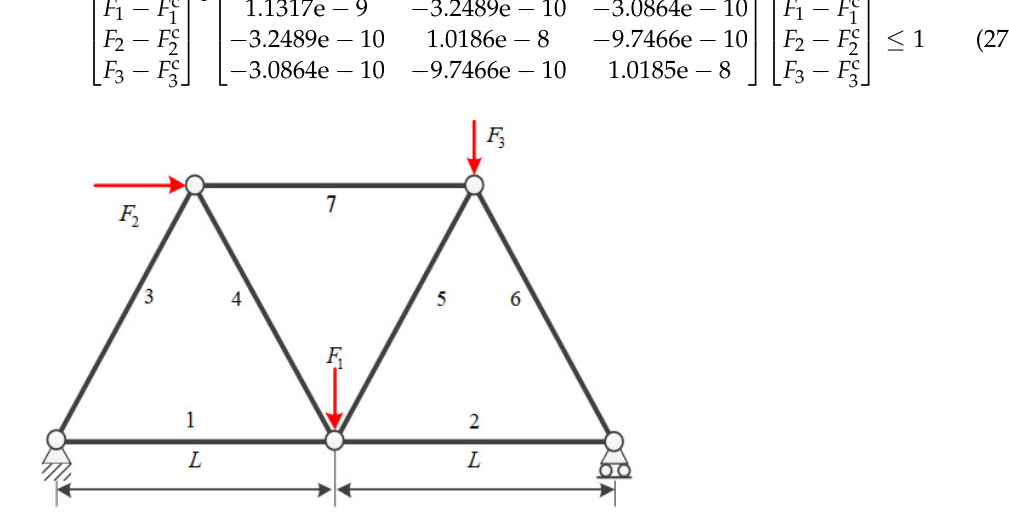
Figure 8. A seven-bar truss.